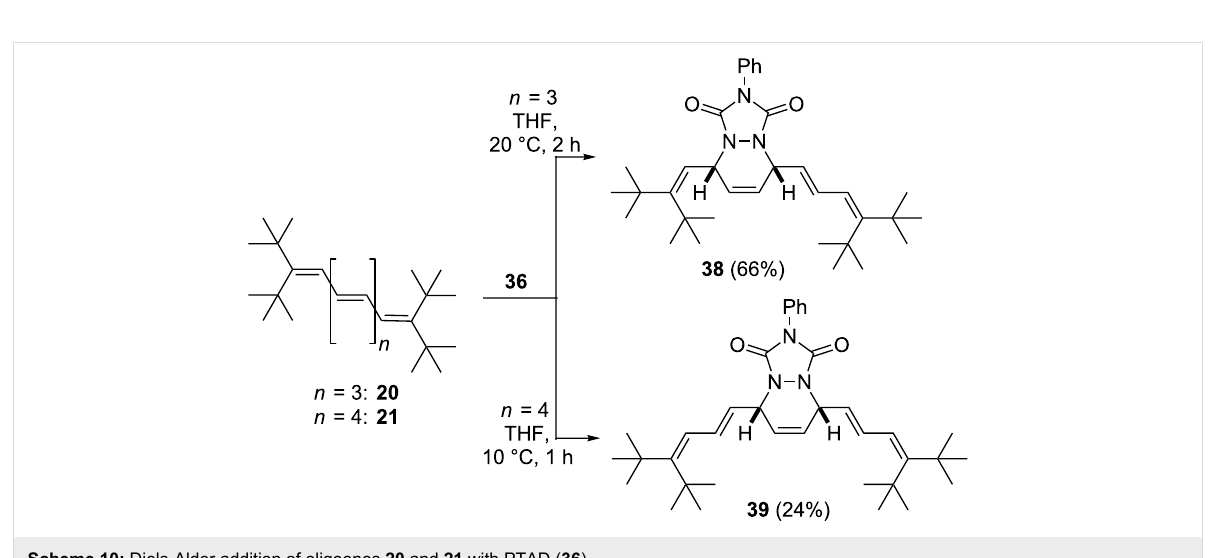
Scheme 10: Diels-Alder addition of oligoenes 20 and 21 with PTAD ( 36 ).